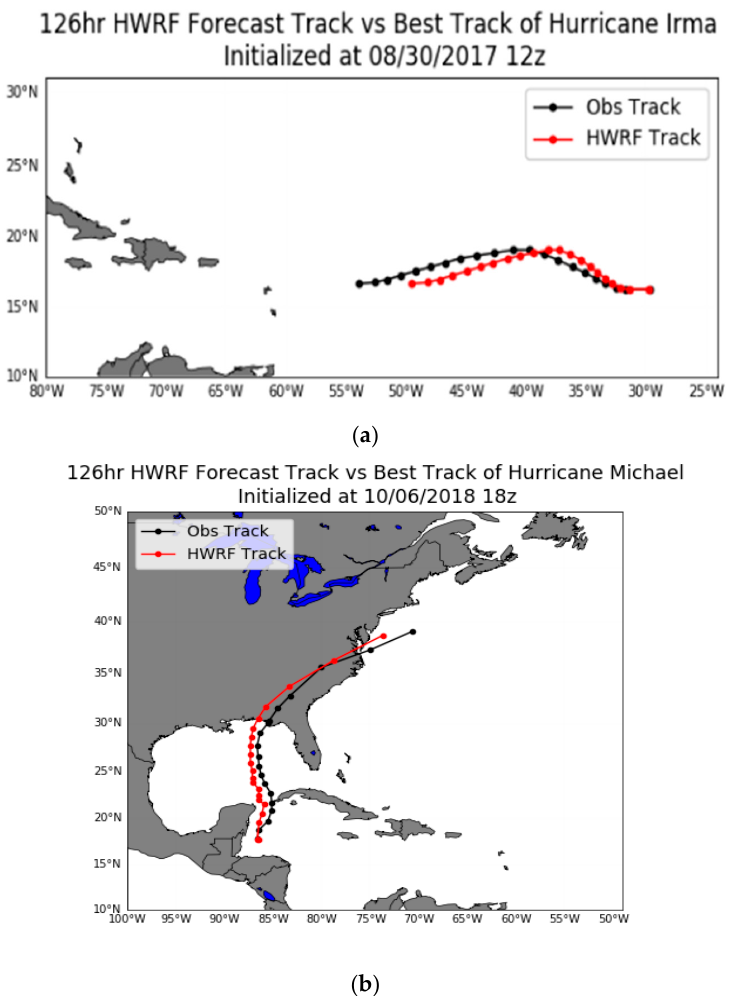
Figure 2. The 126 h HWRF forecast tracks (red) and corresponding observed National Hurricane Center (NHC) best track (black) for ( a ) Hurricane Irma initialized at 1200 UTC on 30 August 2017 and ( b ) Hurricane Michael initialized at 1800 UTC on 06 October 2018. Markers represent the tropical cyclone (TC) position every 6 h.